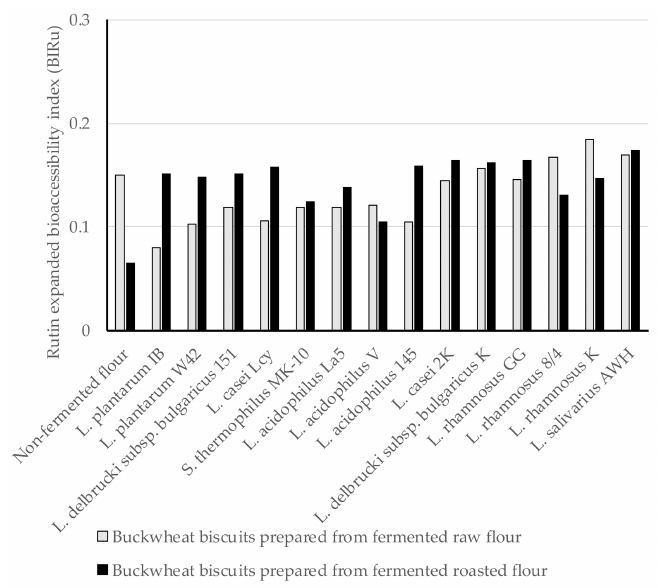
Figure 1. The Ru expanded bioaccessibility index (BI Ru ) from BBs formulated from buckwheat flours fermented by lactic acid bacteria; BI Ru value > 1 indicates high bioaccessibility; BI Ru value < 1 indicates low bioaccessibility.